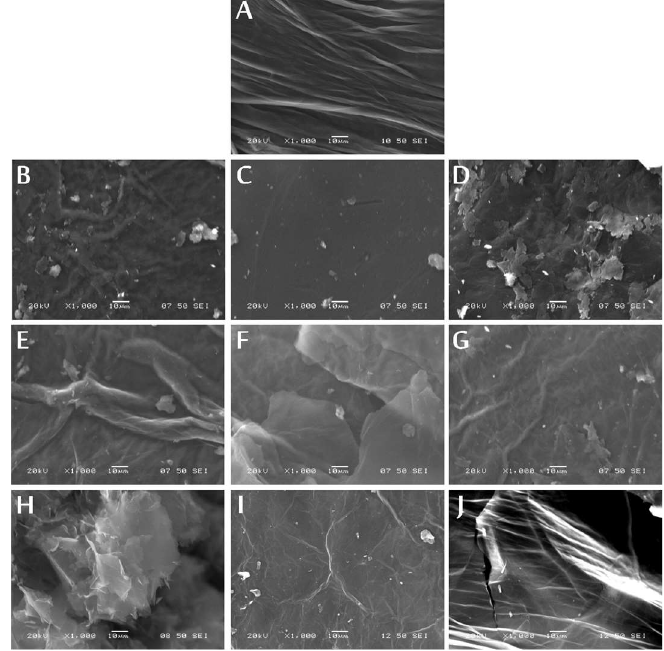
Figure 3. SEM images of the GO ( A ), GO-air 200°C ( B ), GO-N2 200°C ( C ), GO-H2 200°C ( D ), GO-air 300°C ( E ), GO-N2 300°C ( F ), GO-H2 300°C ( G ), GO AA ( H ), GO-N2 900°C ( I ) and GO-H2 900°C ( J ).